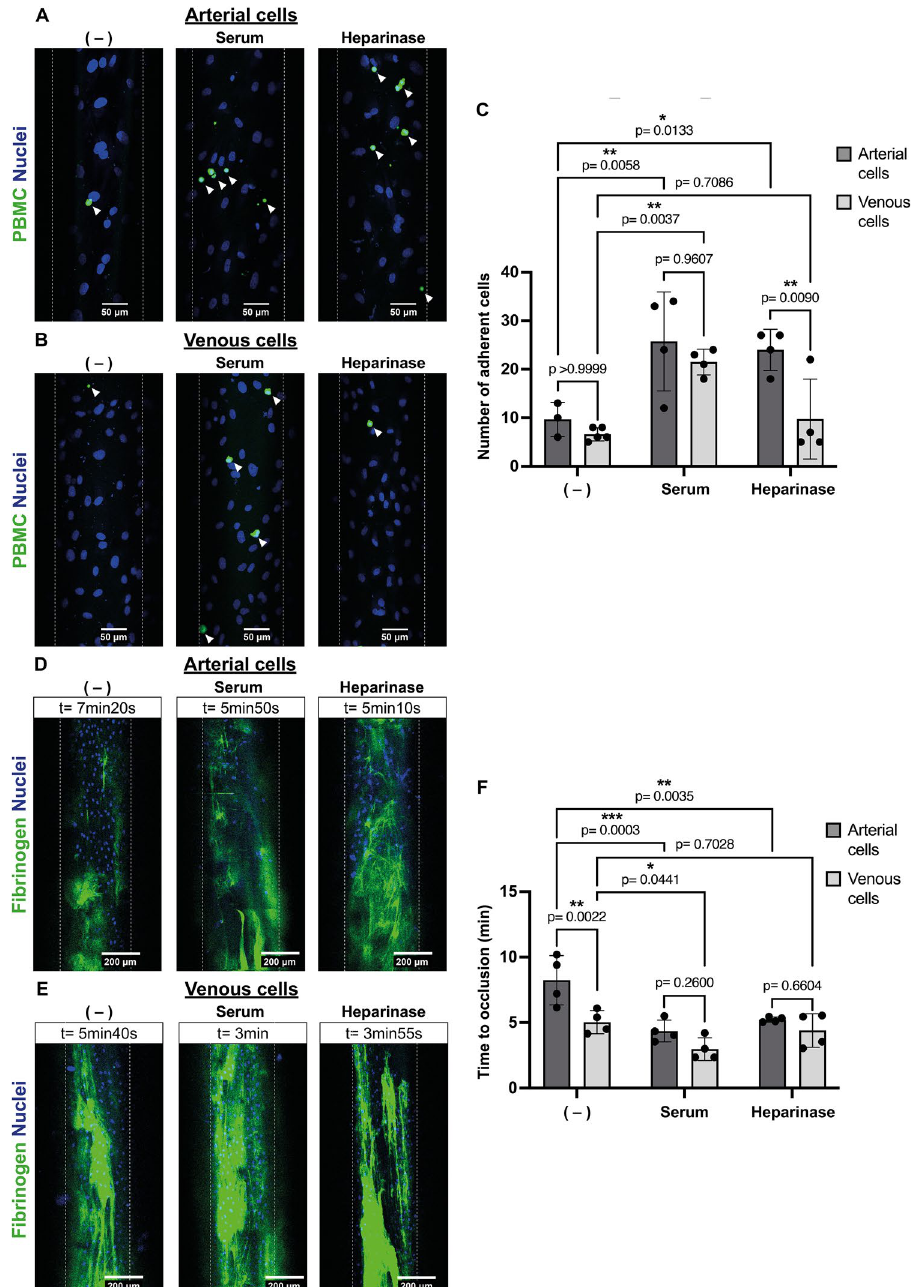
Figure 3. Persistence of heparan sulfate on venous cells after xenogeneic activation fails to prevent leukocyte adhesion and clot formation. ( A , B ) Representative images of 3 time-lapse recordings of binding of human peripheral blood mononuclear cells (PBMCs; shown in green) to ( A ) arterial and ( B ) venous porcine endothelial cells left untreated (−) or perfused with either 10% normal human serum (Serum) or 5 U/ml heparinase (Heparinase). Nuclei of cells are shown in blue (Hoechst). Scale bar: 50 μm. ( C ) Adherent PBMCs were quantified from 20 min time-lapse recordings of four independent experiments by counting cells immobilized for ≧ 3 s. ( D , E ) Representative images of fibrin clots (green) forming on ( D ) arterial or ( E ) venous porcine ECs. Cells were left untreated (−) or perfused with either 10% normal human serum (Serum) or 5 U/ml heparinase (Heparinase) prior to addition of recalcified citrated human plasma spiked with AlexaFluor488 labeled human fibrinogen (green). Scale bar: 200 μm. ( F ) Time to occlusion was determined as complete channel occlusion or cell detachment and quantified from time-lapse recordings of plasma perfused channels. Data are from four independent experiments, 2–3 different porcine ECs donors and were analyzed using Fiji software. Two-way ANOVA with Tukey and Bonferroni post-hoc test was used for statistical